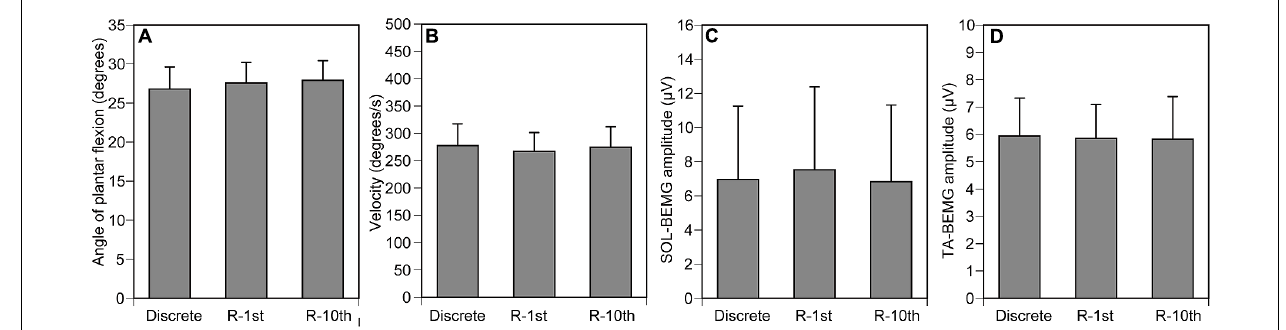
FIGURE 4 | Controlled variables for Section “Experiment 1.” Ankle angle (A) , ankle velocity (B) , and SOL- (C) andTA-BEMG (D) amplitude when tibial nerve stimulation was delivered. Bars indicate mean and error bars indicate standard error of mean.